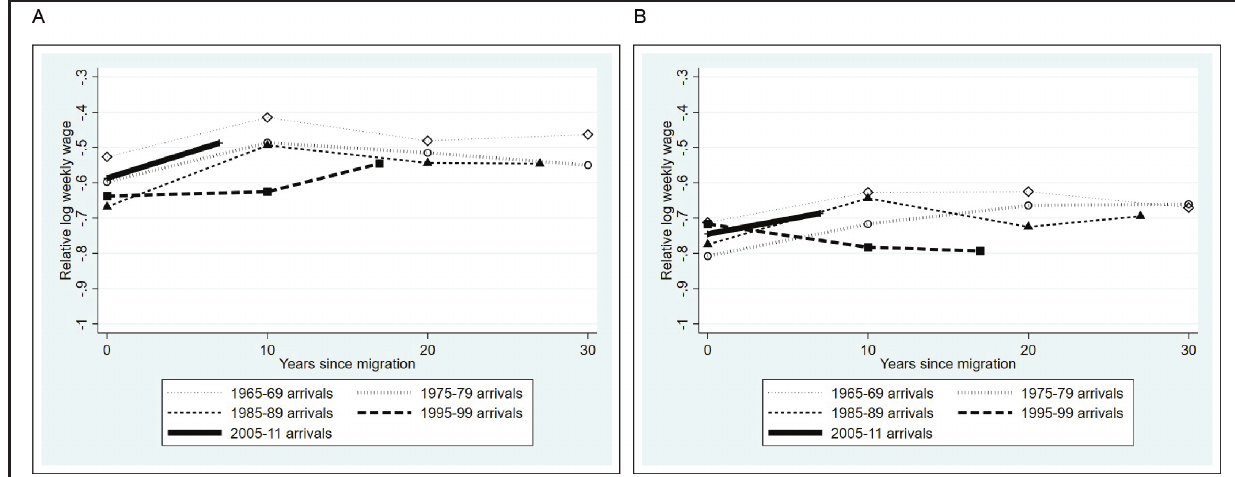
Figure 4 Age-adjusted convergences for the relative log weekly earnings of Mexican and Central American immigrant cohorts by location: initial gaps and convergences. (A) rural; (B)